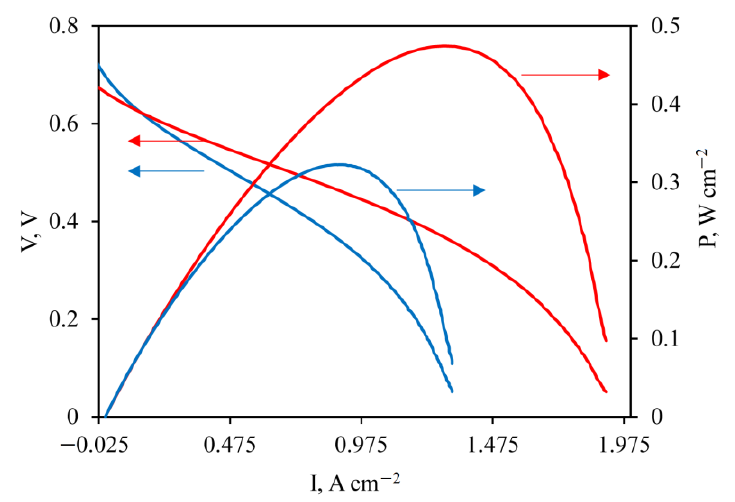
Figure 9. Polarization curves and power density data for MEA with the reinforced PBI/KH 560-0.3 membrane at 150 °C (blue) and 200 °C (red).